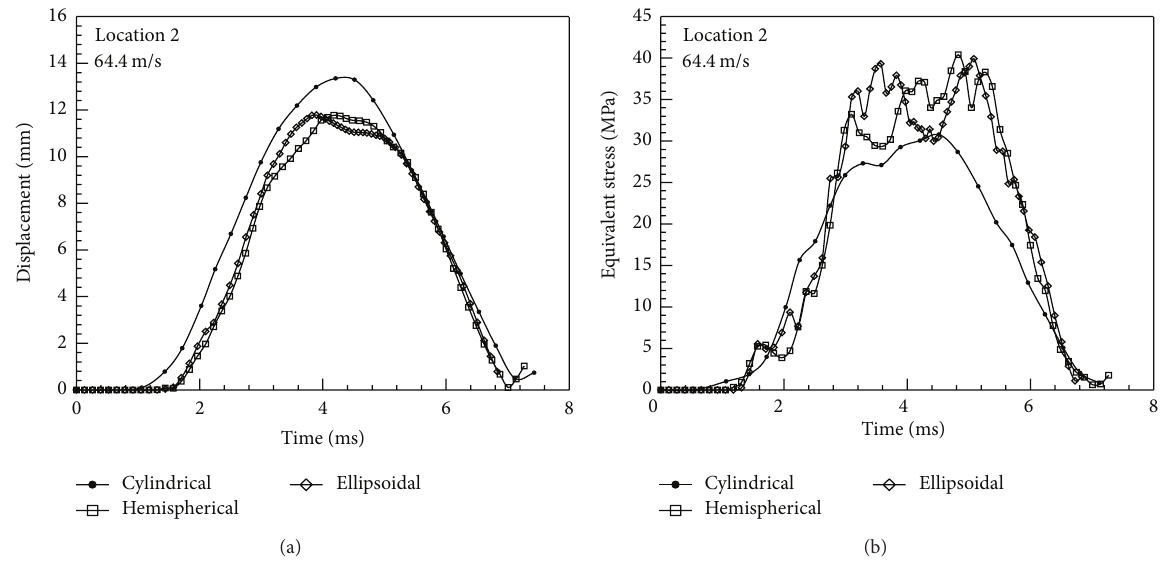
Figure 21: Effect of bird shape on (a) maximum normal displacement and (b) equivalent